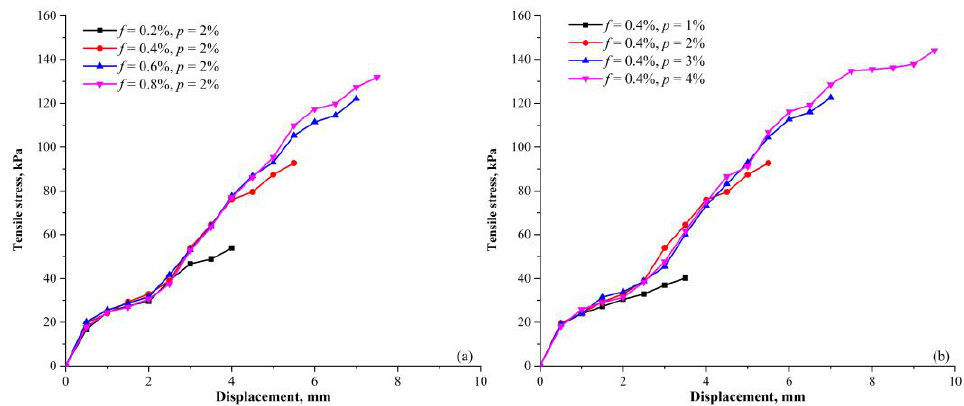
Figure 13. The typical tensile curves of specimens with different ( a ) PF content and ( b ) PU content ( t = 48 h and ρ d = 1.50 g/cm 3 ).